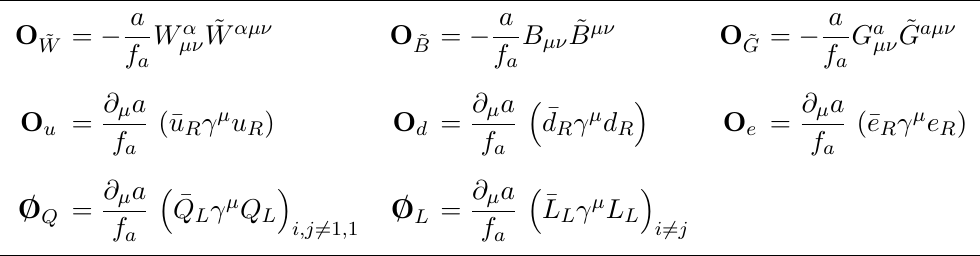
Table 1 . A complete and non-redundant basis of bosonic+fermionic operators, in the presence of quark mixing. Each fermionic structure is a n { i, j } left implicit except in the operators on the last row (which become redundant — for n g = 1 ). For the anomalous terms, a “hatted” renaming will be used when convenient, ˆ O see